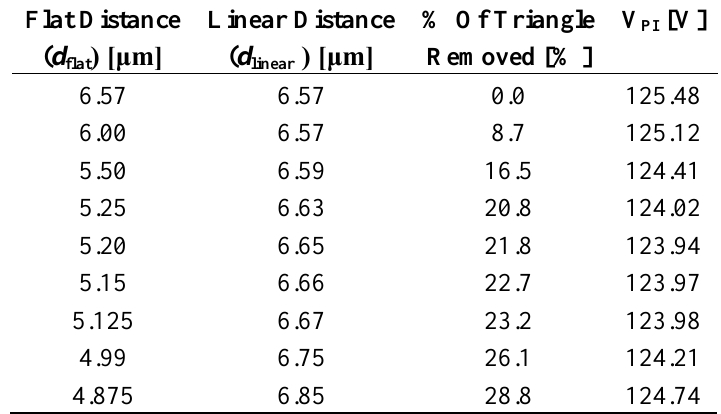
Table 6. Linearly varying gap with flattened bottom case results (required 2 μm